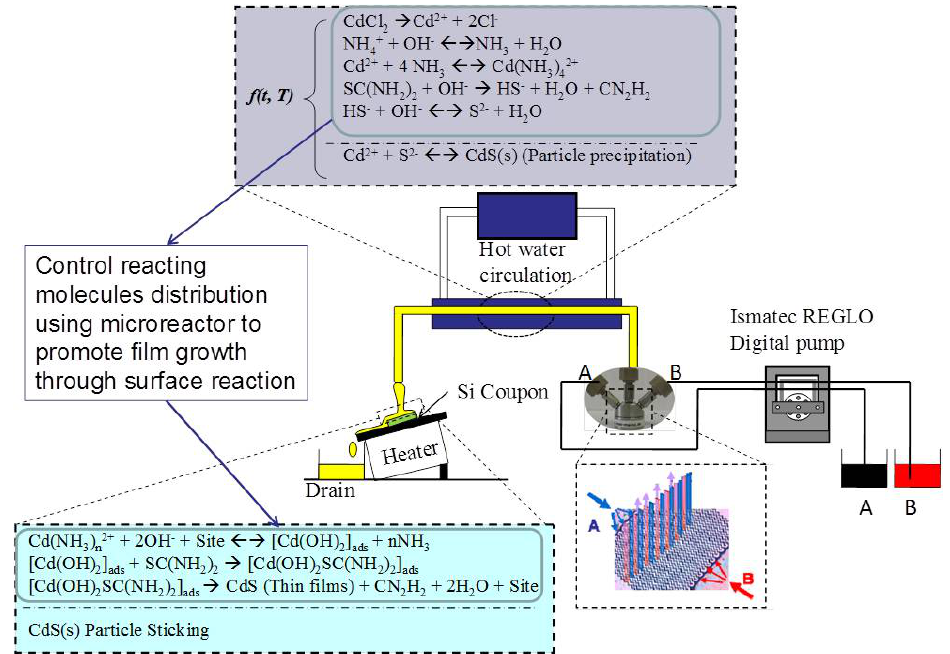
Figure 4. Scheme of the microreactor-assisted solution deposition (MASD) technique for CdS film deposition. Reproduced from